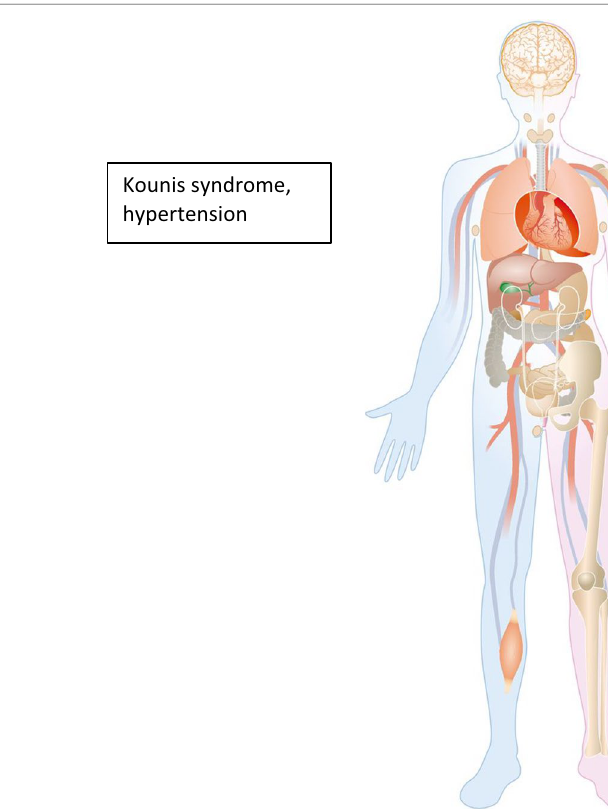
Fig. 1 Involved systems in chronic urticaria and relevant